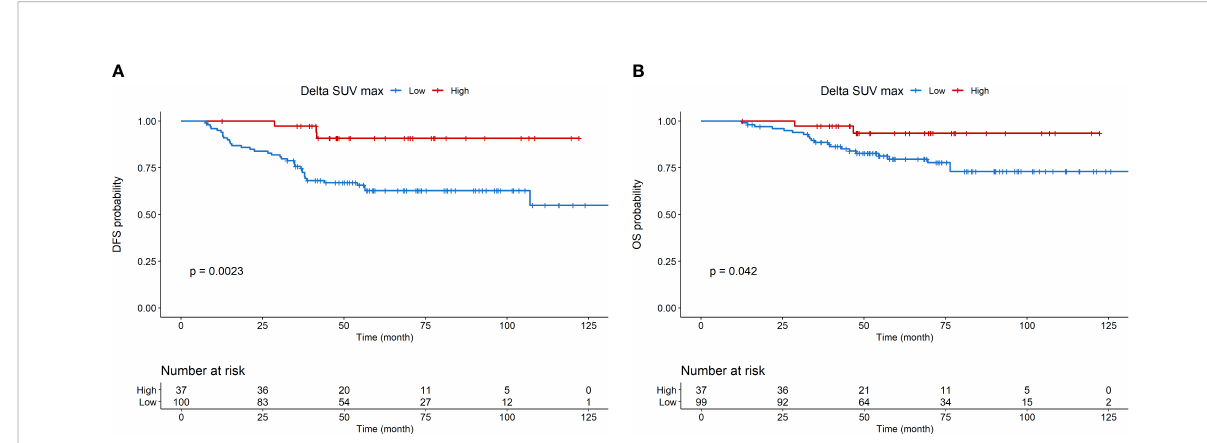
FIGURE 2 Disease-free survival (A) and overall survival (B) according to Delta SUVmax.